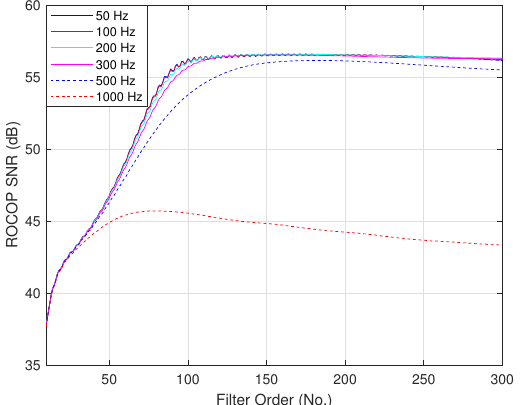
Figure 8. ROCOP SNR to filter order response curves constructed for filter cutoff frequencies of 50 Hz, 100 Hz, 200 Hz, 300 Hz, 500 Hz and 1000 Hz.